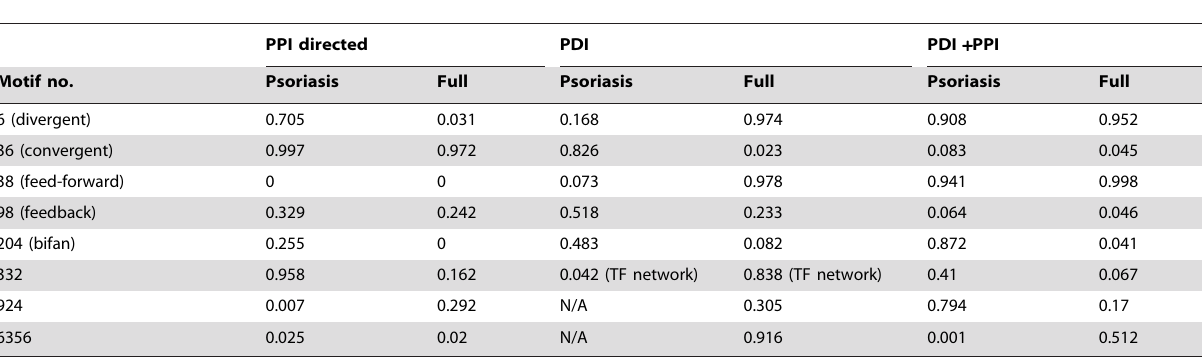
Table 5. Summary of network motif